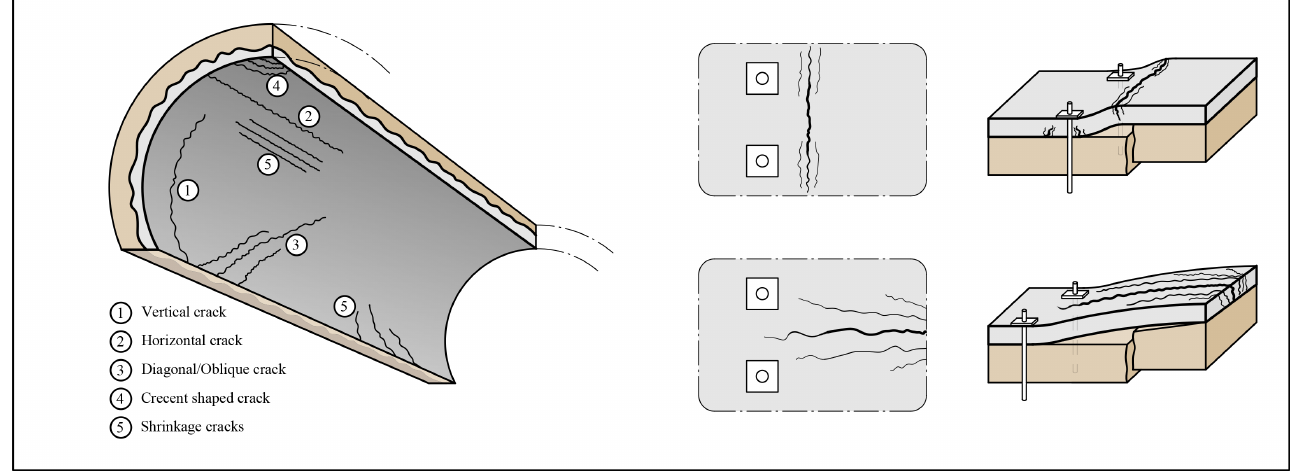
Figure 3. Different orientations of structural cracks and possible causes [23] and possible crack patterns for concrete lining subjected to the load from a loose block